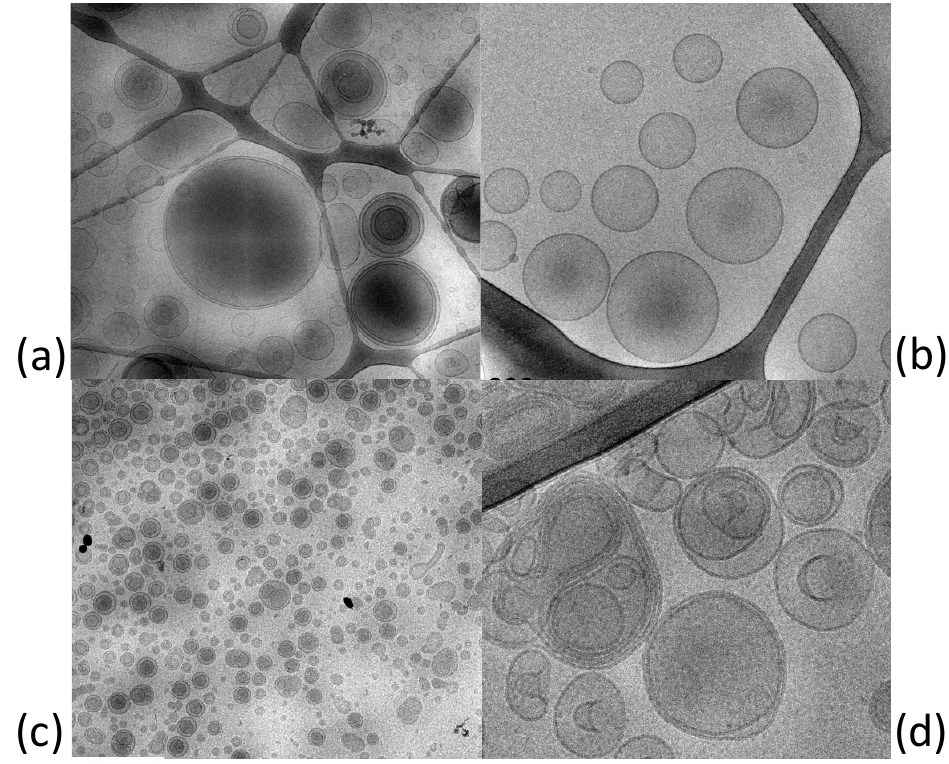
Figure 2. Cryo-TEM images of exemplary LBNs cited in this review: ( a ) liposomes; ( b ) transferosomes; ( c ) niosomes; ( d ) ethosomes. Bar corresponds to 500 nm ( a , c ) and 200 nm ( c , d ).